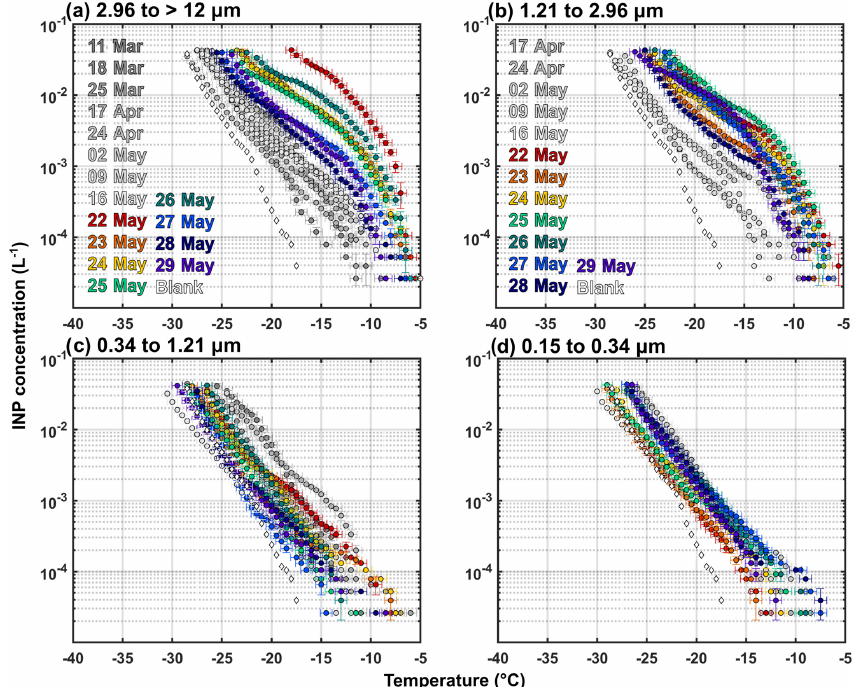
Figure 3. Cumulative INP spectra for the four size-ranged samples of the DRUM impactor from INPOP ( a – d represent stages A–D, respec- tively). One daily sample per week is shown from 11 March to 16 May and 17 April to 16 May for stages A and C and stages B and D, respectively. Daily samples are shown from 22 to 29 May for all stages. White diamond markers denote the blank Mylar sample in UPW prepared in the same manner as the samples. This blank spectrum applies to all size